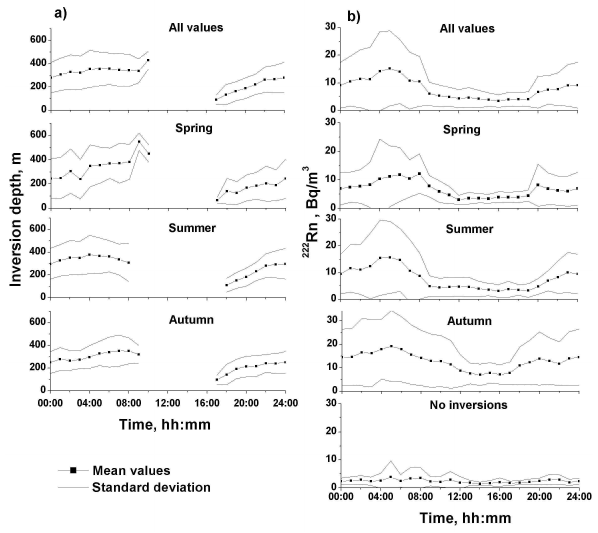
Fig. 3. The mean diurnal cycles of temperature inversion height (a) and 222 Rn concentration (b) from TROICA expeditions.